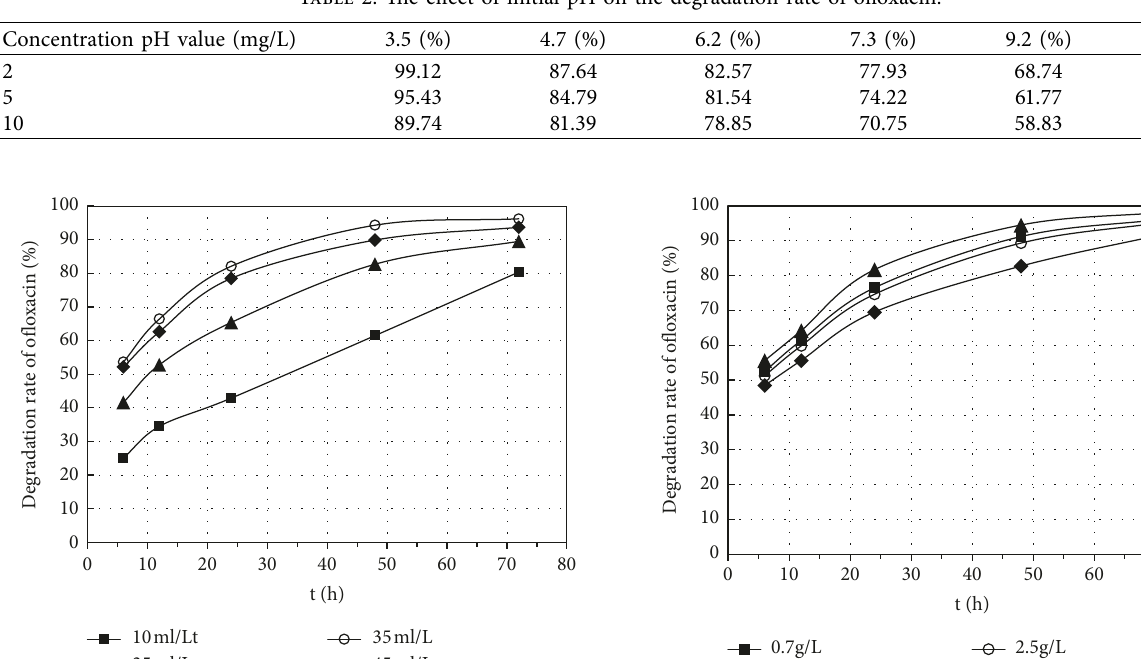
Figure 9: The effect of H 2 O 2 concentration on the degradation rate of ofloxacin.